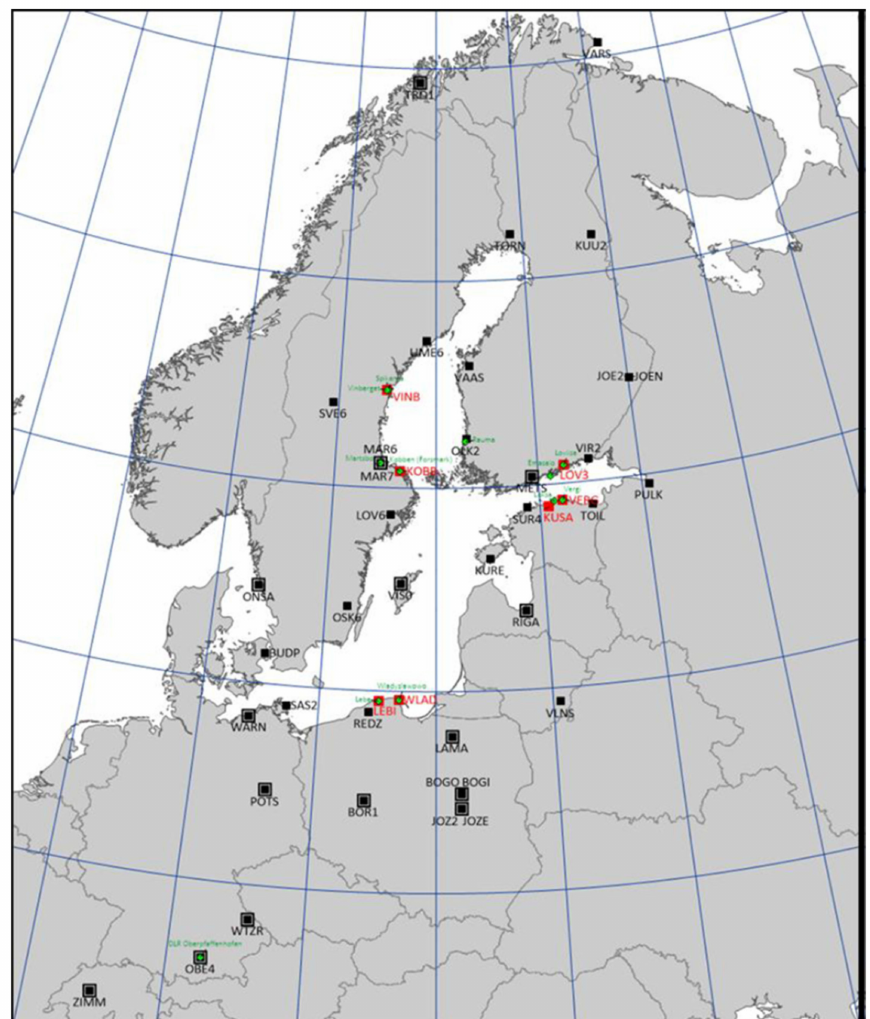
Figure 9. Map with distribution of all included GNSS stations. Large black squares are the IGS network stations, smaller black squares are the EPN stations, and red squares are the stations belonging to the EUPOS (FinnRef, ESTPOS, SWEPOS and ASG-EUPOS). Only LEBI station belongs to Leica commercial network. Little green diamonds indicate the locations of the ECR